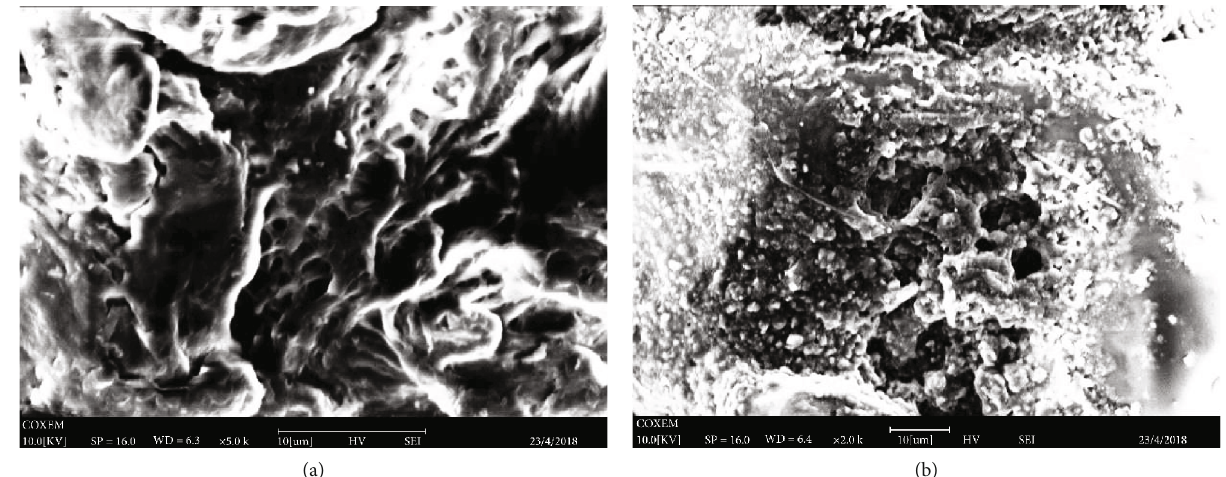
Figure 4: Scanning electron micrographs of chitosan (left) and sulfonated chitosan (right).